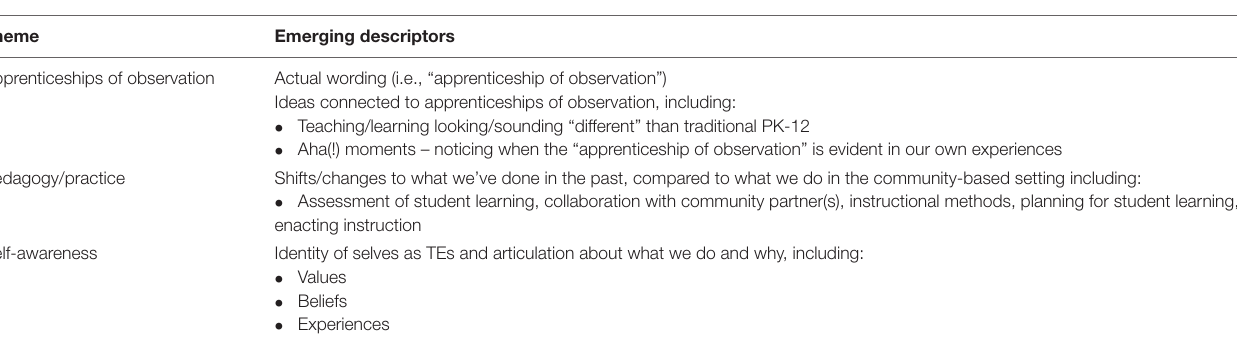
TABLE 4 | Independent thematic analysis coding (round